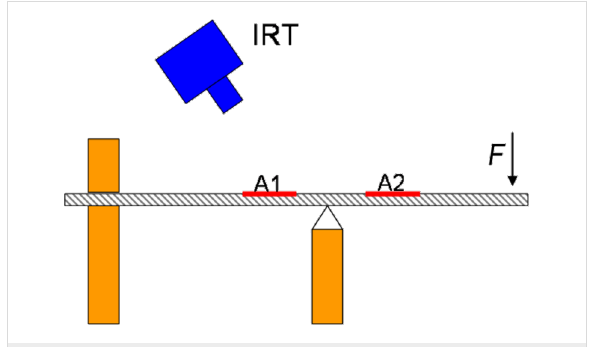
Figure 3: Sketch of the setup used for the thermographic analysis of the PMMA/nanocomposite